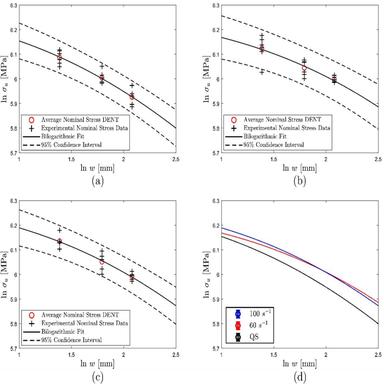
Bilogarithmic size effect fittings: (a) quasi-static (QS); (b) 60 s − 1 (IR 1); (c) 100 s − 1 (IR 2); and (d) a comparison.